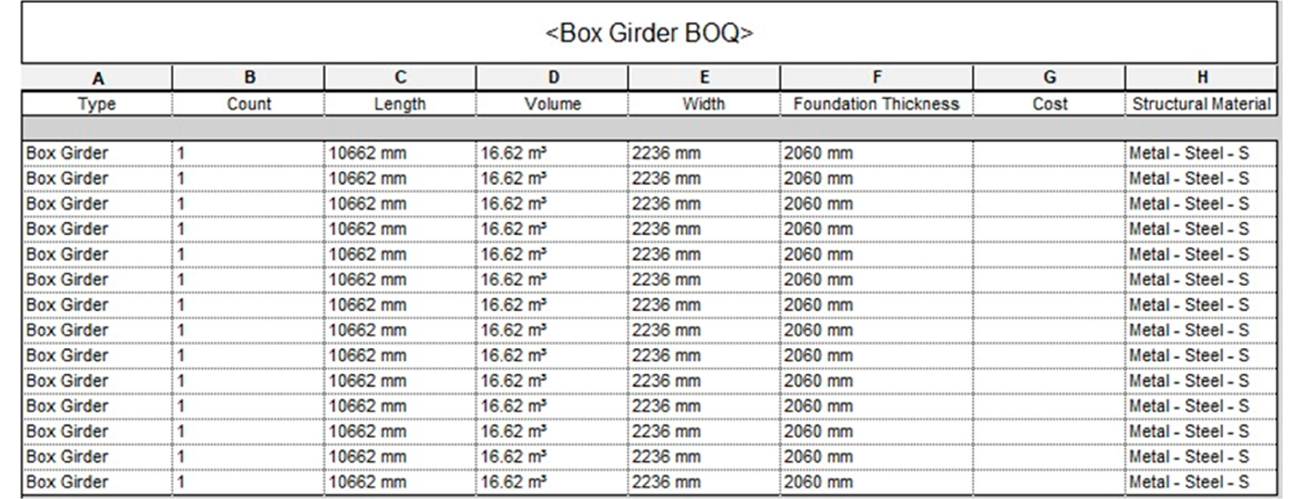
Figure 7. An example of the bill of quantities (BoQ) of steel box girder components installed on the bridge.